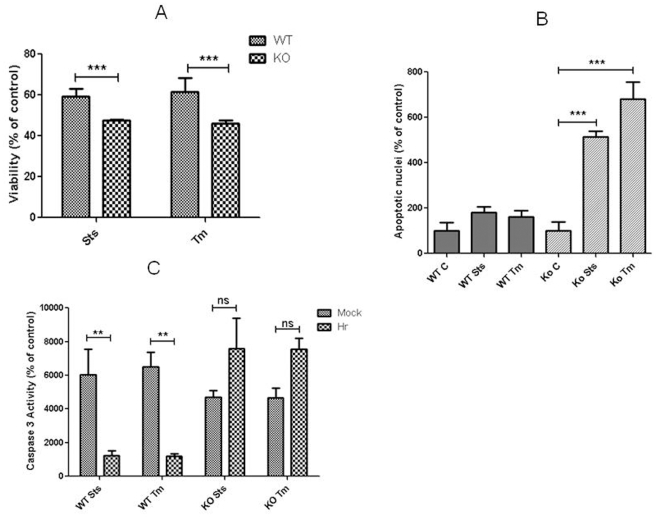
p53 is required for Hr to attenuate apoptosis.MEF from p53 wild-type (wt) and knockout (ko) mice were transfected with Rk5Hr and apoptosis was induced in cultures with staurosporine (sts) and tunicamycin (tm). Viability was measured with the MTT assay and repeated in three independent experiments in triplicate (A). The number of apoptotic nuclei was counted with DAPI staining (B). Caspase 3 activity was determined in a colorimetric assay and repeated in three independent experiments in triplicates (C). Data for viability and caspase 3 are expressed as percent control (not treated with chemicals). The percent apoptotic nuclei was determined by dividing the number of fragmented nuclei by the total number of nuclei and multiplied by 100. Data are expressed as means ± S.E.M. ** and *** indicates significantly difference between knockout and wild-type at p<0.01 and p<0.001, respectively, which was determined with ANOVA and Tukey's post hoc test.